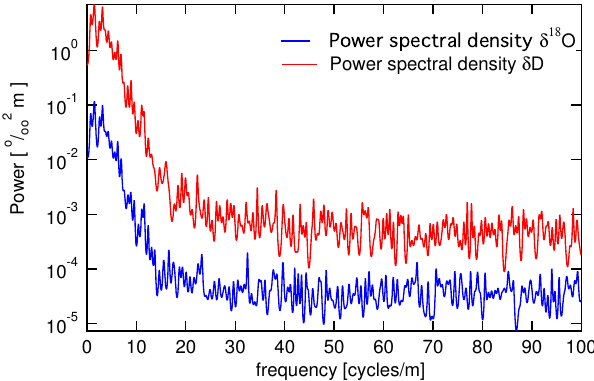
Fig. 5. δ 18 O and δ D power spectral density based on the data of the interval 1382.152 – 1398.607 m